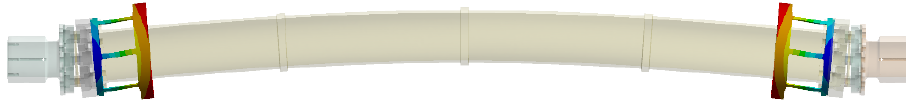
Figure 8. Finite element obtained first bending mode of shaft with short sleeve.